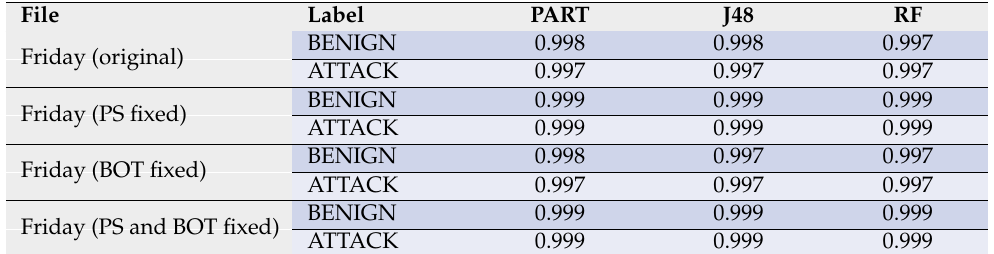
Table 20. F1 performance results using Zeek over different labelling corrections in Friday file.